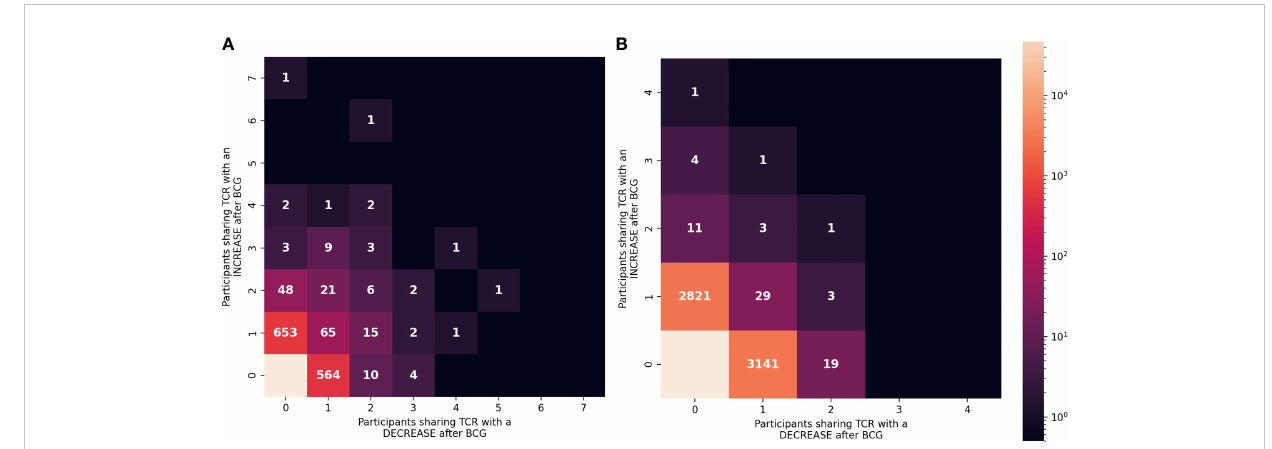
FIGURE 6 Consistency of the changes observed after BCG vaccination among TCR g and TCR d repertoires. (A) TCR g and (B) TCR d repertoires were analyzed to identify TCRs from each participant that either increased or decreased signi fi cantly after BCG vaccination (Fisher ’ s exact test, FDR-adj q-value < 0.05). Each unique TCR was categorized based on the number of individuals that shared the TCR and showed a signi fi cant increase or decrease after BCG vaccination. Each category (one box) is colored based on the number of unique TCRs (out of 106,946 TCR g or 103,462 TCR d clonotypes) with the corresponding number of people with an increase (y-axis) or decrease (x-axis). Leftmost column shows TCRs that exclusively increased in ≥ 1 participant and bottom row shows TCRs that exclusively decreased in ≥ 1 participant (except bottom left box which indicates that the majority of TCRs did not signi fi cantly change in frequency after BCG